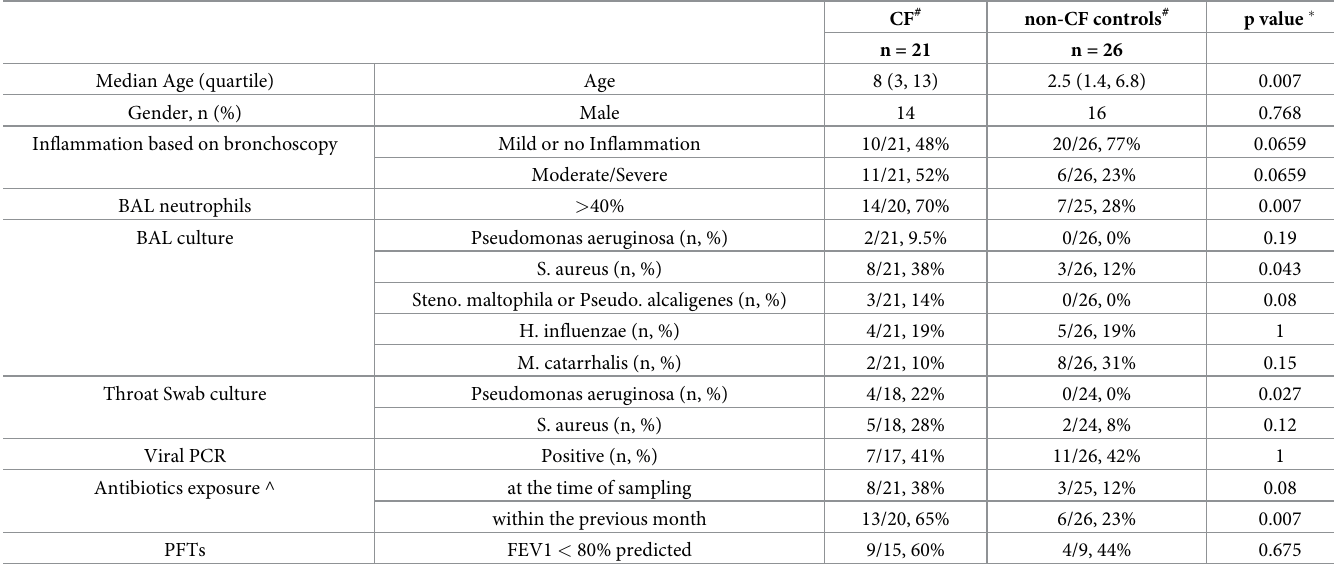
Table 1. Clinical characteristics of subjects in this